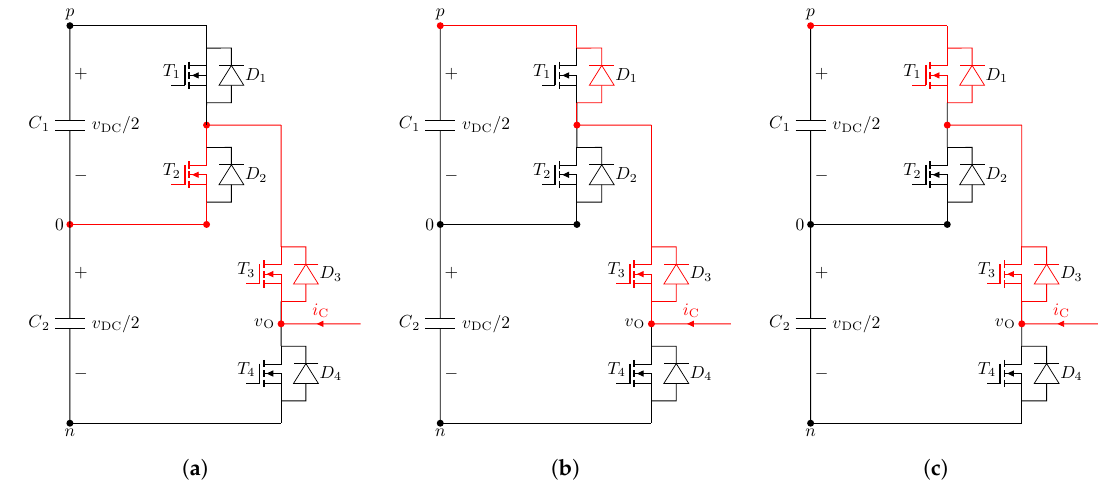
Figure 7. Current commutation, transition from switching state 0 to p for I C < 0. Current flow depicted in red. ( a ) Switching state 0 . ( b ) Blanking time (between T1 and T2 ) interval. ( c ) Switching state p .